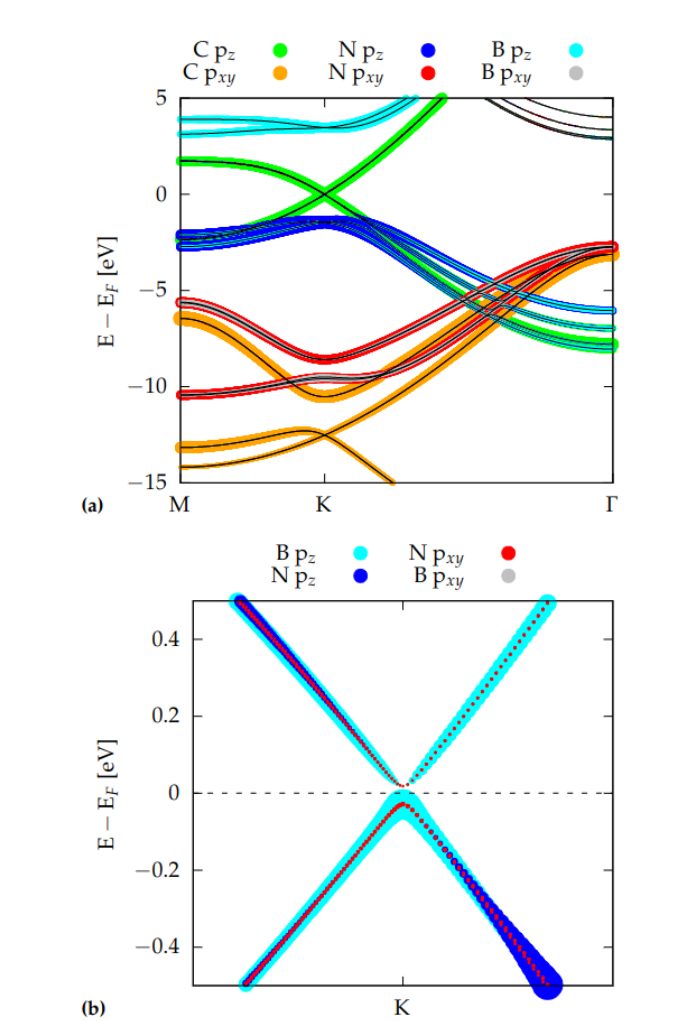
Figure 3. ( a ) k-resolved projected density of states (k-DOS) for the AB-AA (cid:48) -AB HT. Colored dots indicate atomic orbitals; ( b ) zoom of the k-DOS near of the Dirac cone, after subtraction of the C states contribution. In both of the plots, the size of the dots is proportional to the weight of the contribution. In ( b ), the dot size is enlarged by a 200 factor in order to make them clearly